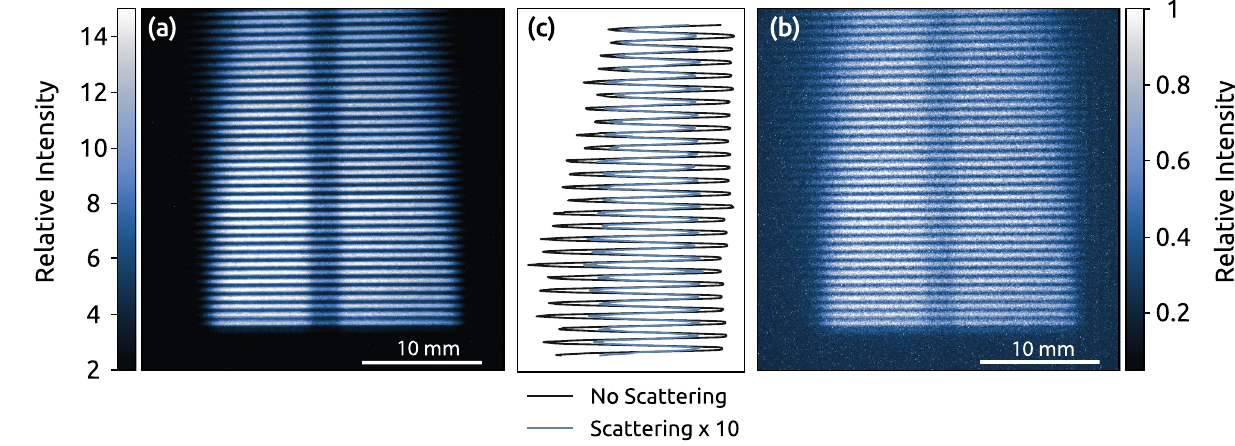
Figure 5. Raw data PLIF images ( a ) without additional scattering yields a contrast of M 0.44. ( b ) Imaging ≈ through scattering media (OD 1) reduces the contrast, M 0.37. ( c ) Cross sectional data, from the central ≈ ≈ radial position, display the difference in modulation for figure ( a ) and ( b ). Note that the signal intensity is about one order of magnitude lower when signal is collected though a scattering